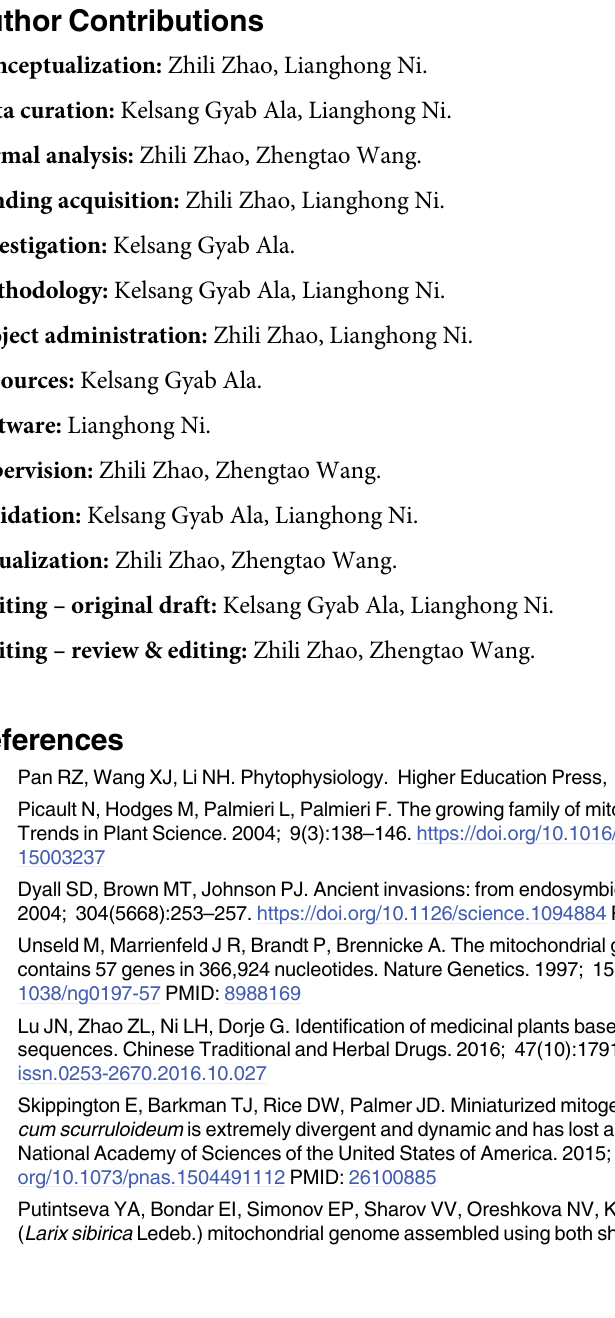
S10 Table. Information of structural variation analysis of Gentiana crassicaulis (Target) and G . straminea (Query). S11 Table. Information exchange and transfer between chloroplasts and mitochondria in Gentiana crassicaulis and G . straminea . S12 Table. Pan genes of 6 Gentianales